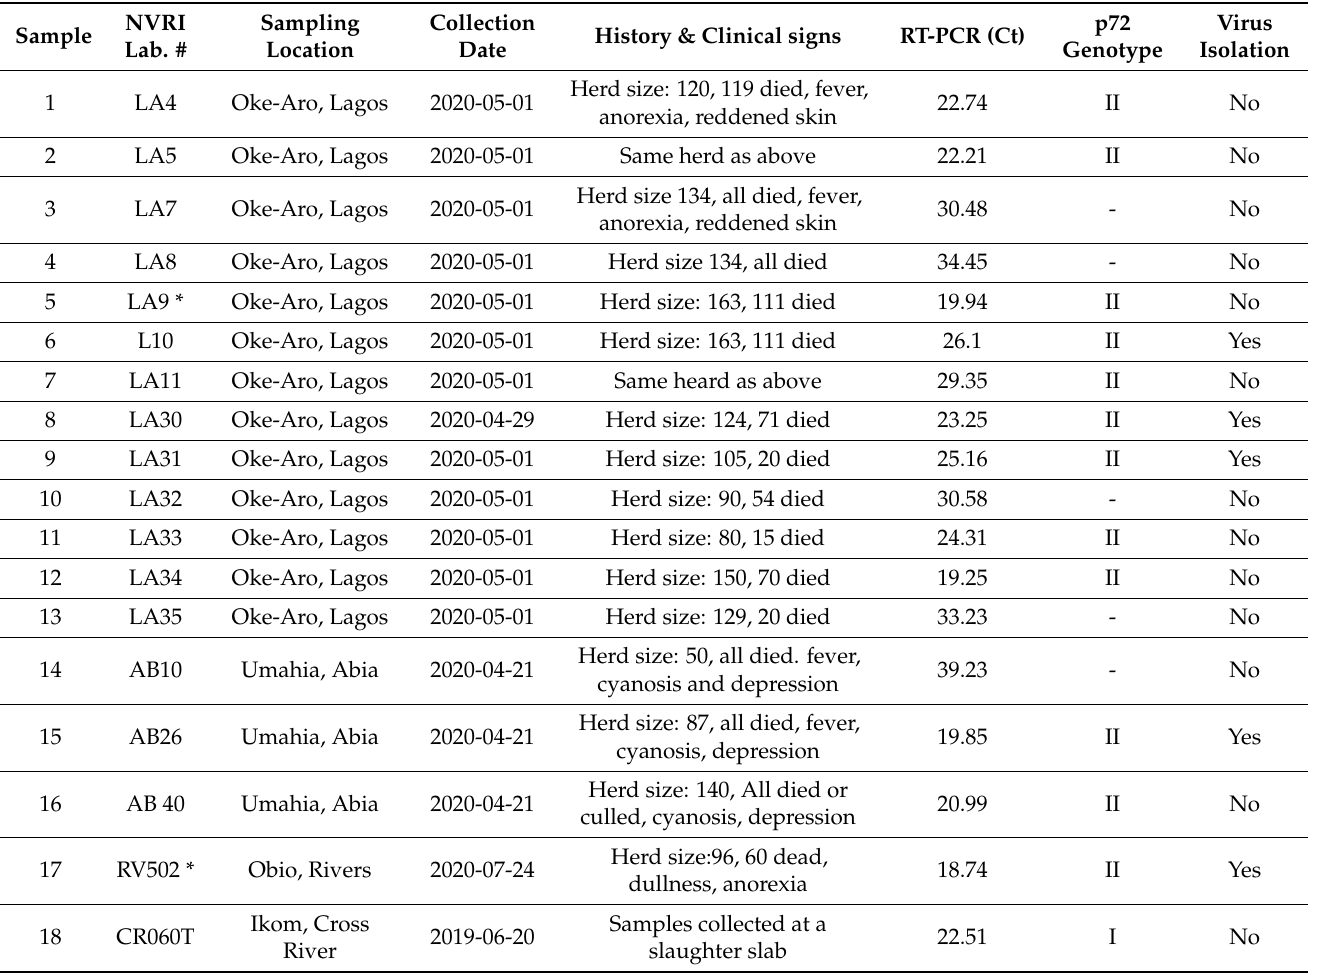
Table 1. History and the summary of laboratory results for the samples tested at the NCFAD. * Sample subjected to whole genome sequencing. (# =